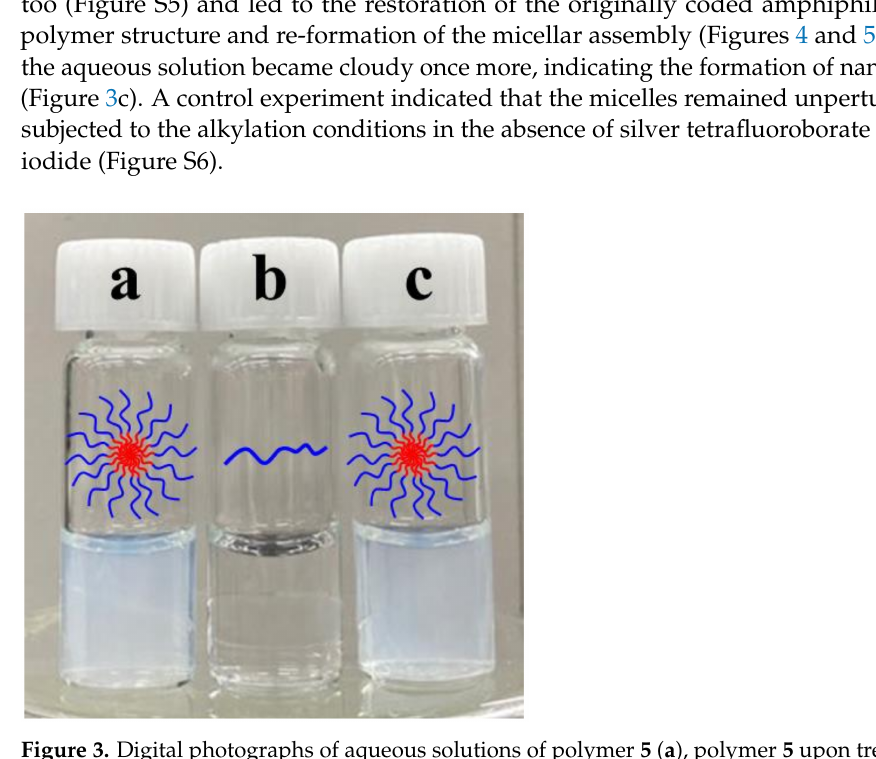
Figure 3. Digital photographs of aqueous solutions of polymer 5 ( a ), polymer 5 upon treatment with methyl iodide and silver tetrafluoroborate ( b ), and upon treatment with APDC ( c ).